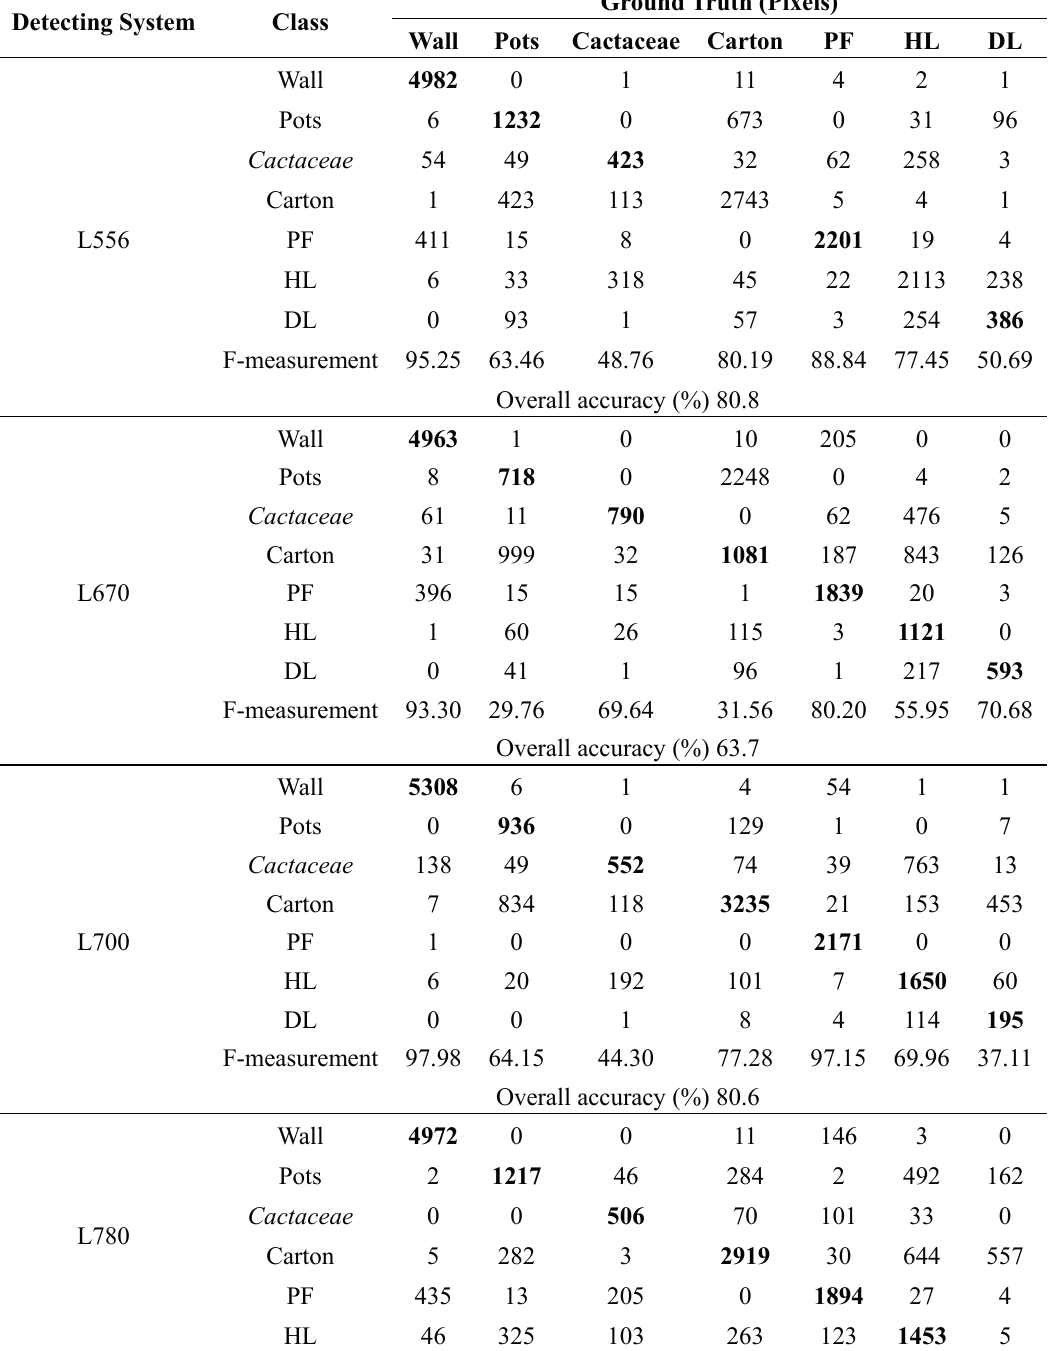
Table 1. Confusion matrices of classification, F-measurement and overall accuracy of SVM classification with features from L556, L670, L700, L780, multispectral image with four bands, and MSL (where PF represents plastic foam block, HL represents healthy leaves of E. aureum , and DL represents dead leaves of E. aureum